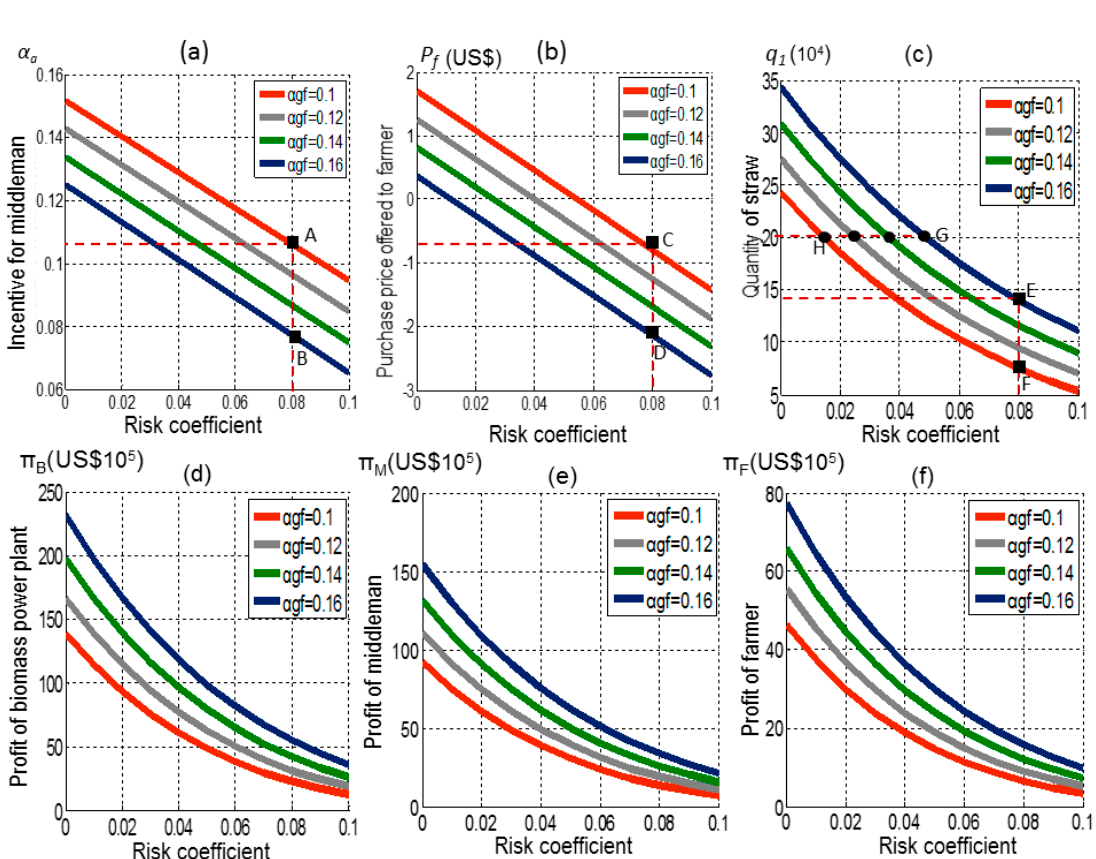
Figure 5. α a , p f , q 1 and changes of profitsunder risk perception in incentive for the farmer situation. ( a ) Description of α a change; ( b ) Description of p f change; ( c ) Description of q 1 change; ( d ) Description of profit change of biomass power plant; ( e ) Description of profit change of middleman; ( f ) Description of profit change of farmer.